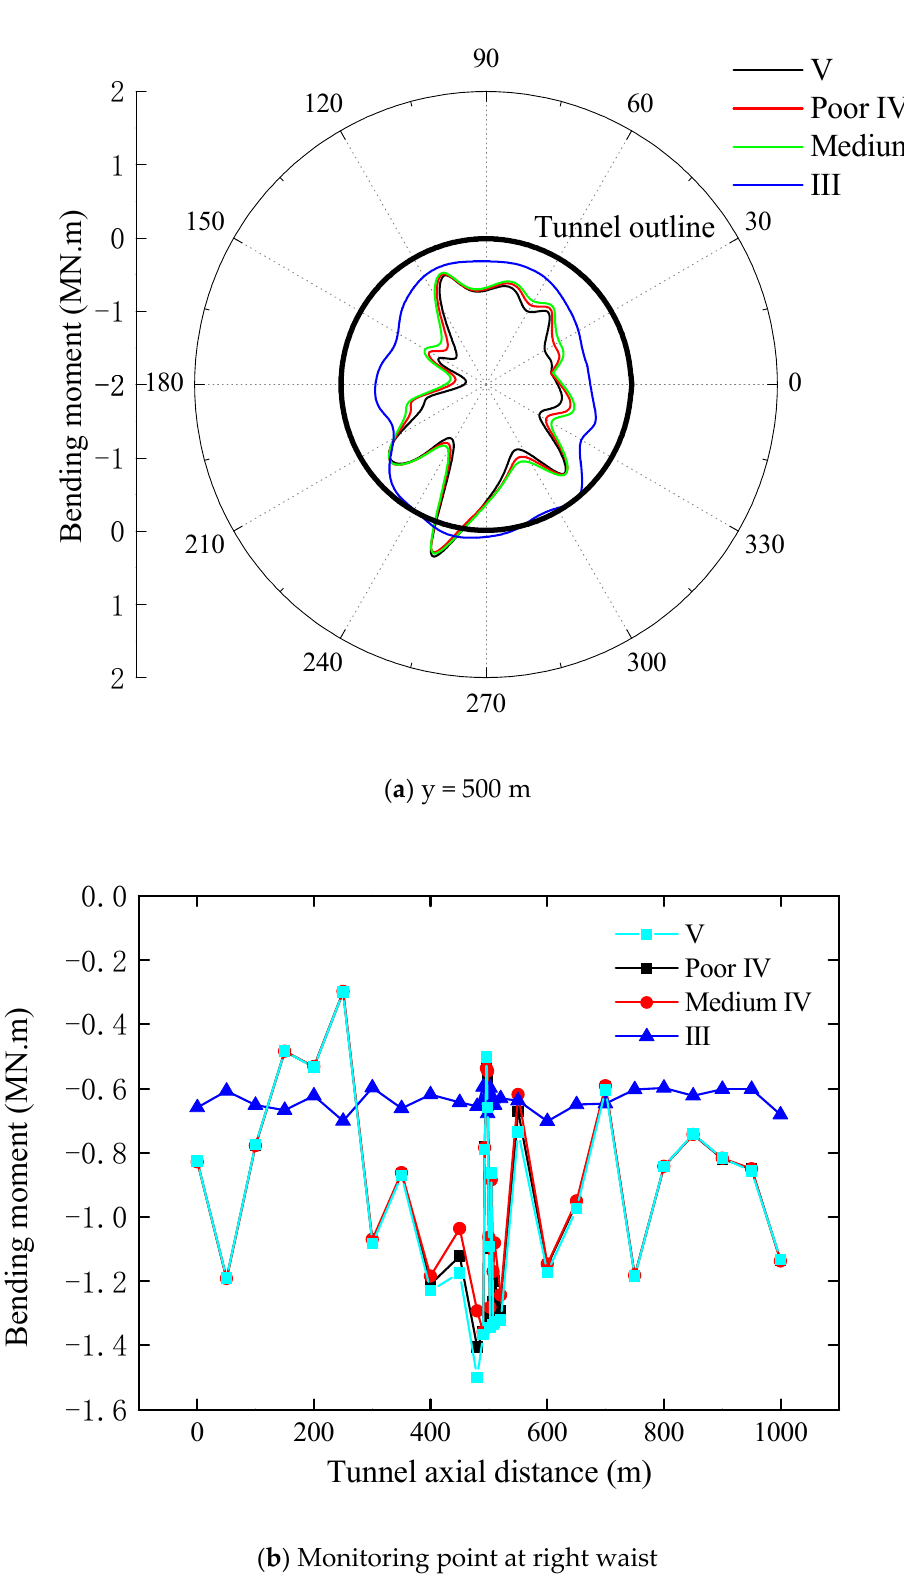
Figure 9. Bending moment of the lining monitoring points of the tunnel passing through adverse geological structure zone with different lithologies.